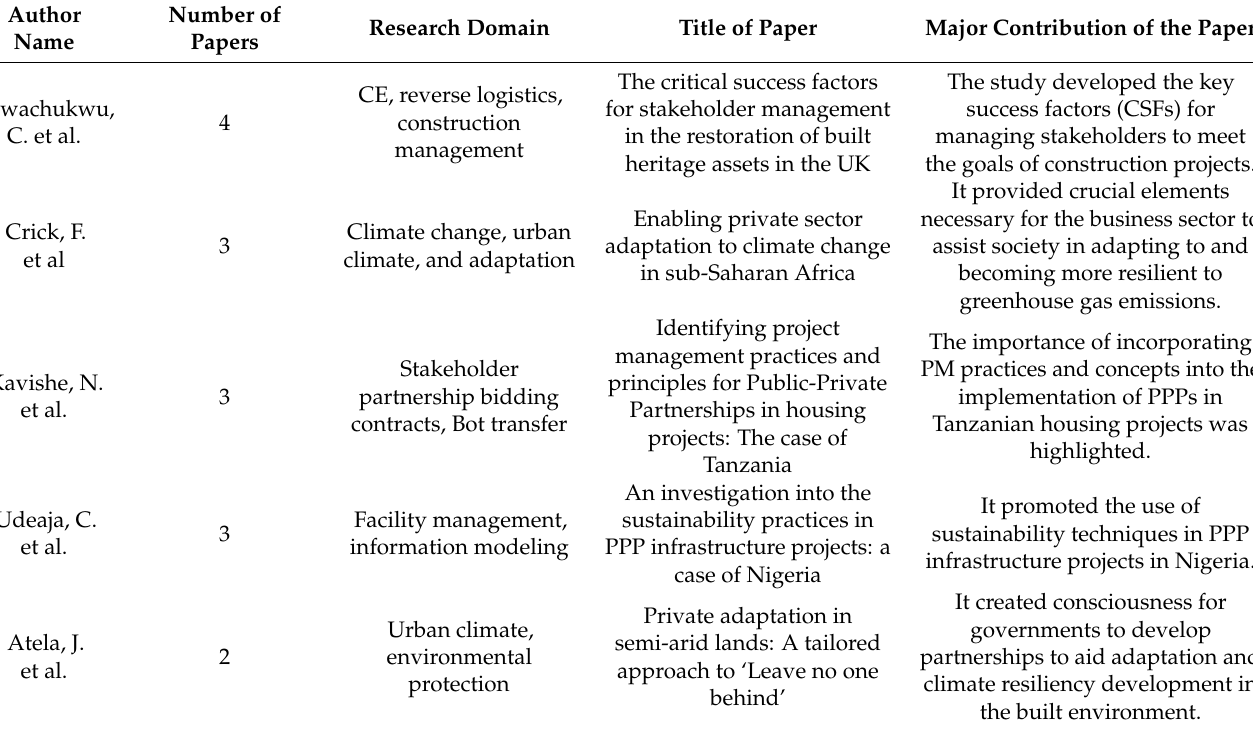
Table 2. Productive co-author